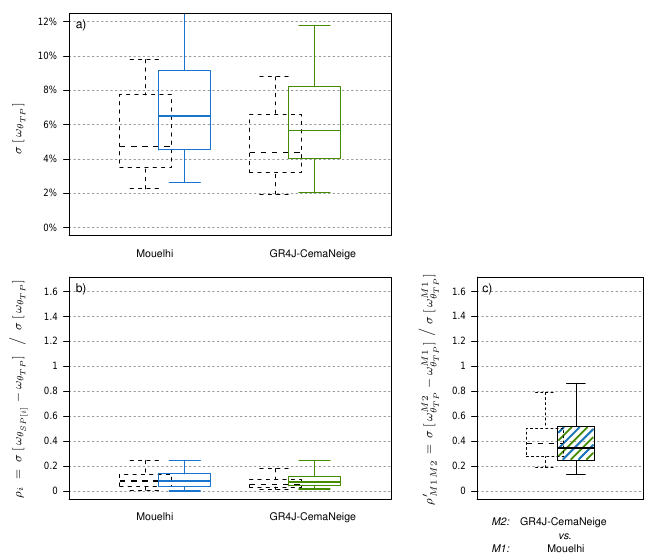
] , ρ i and ρ 0 values obtained for the set of 365 catchments (solid coloured lines) and comparison with Fig. A2. Distributions of σ [ ω θ M 1 M 2 TP the previous results obtained on 20 catchments (dashed black lines).